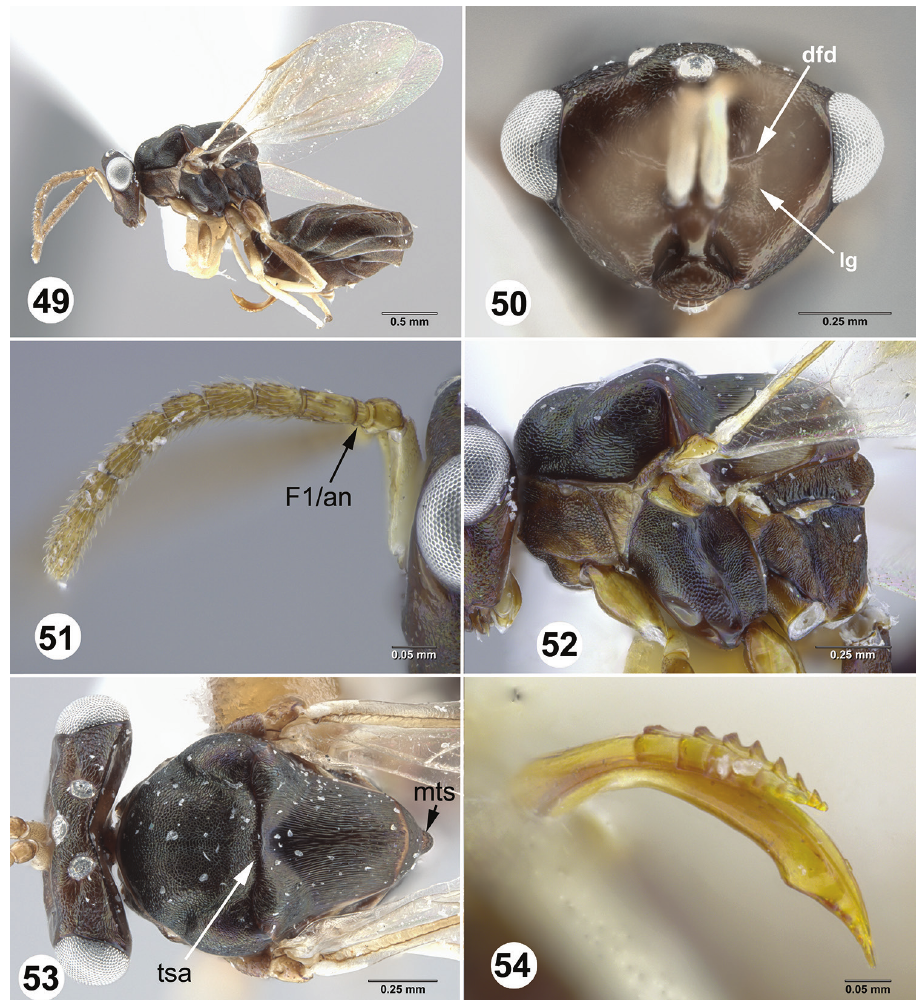
Figures 49–54. Ivieosema limula . Holotype female: 49 habitus, lateral 50 head, anterior 51 antenna, lateral 52 mesosoma, lateral 53 mesosoma, dorsal 54 ovipositor, lateral. dfd = dorsal frontal depression; F1/an = anellus; lg = longitudinal groove; mts = metascutellum; tsa = transscutal articulation. area (Fig. 50, dfd); lower frons with a distinct vertical groove (Fig. 50, lg); scrobal area with a single medial large pit just below median ocellus; supraclypeal area smooth, clypeus shallowly irregularly sculptured, anterior tentorial pits very deep and broad, anteclypeus very short; scrobal depression broadly and shallowly impressed; vertex not carinate. Labrum with 4 digits. Maxillary and labial palps absent. Flagellum 1.2× head height, 7 funiculars; anellus slightly broader than long, expanding apically (Fig. 51, F1); F2 2.0× as long as broad, F2 1.1× as long as